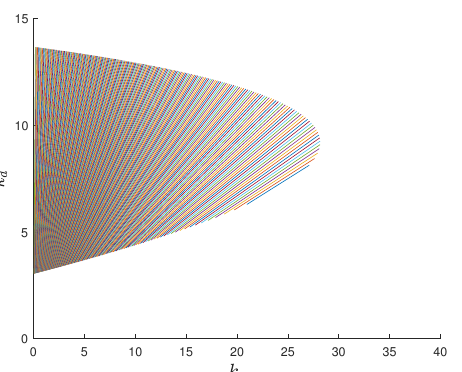
Figure 8. Feasible PD parameter region with p 1 = 1, p 2 = 2 and τ = 0.1.